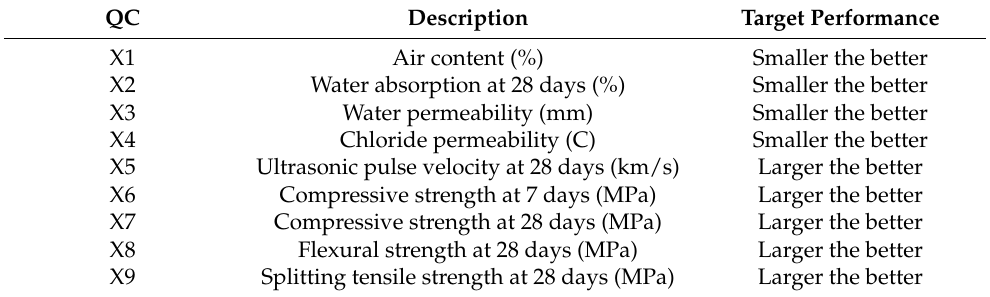
Table 2. QC and target performance.